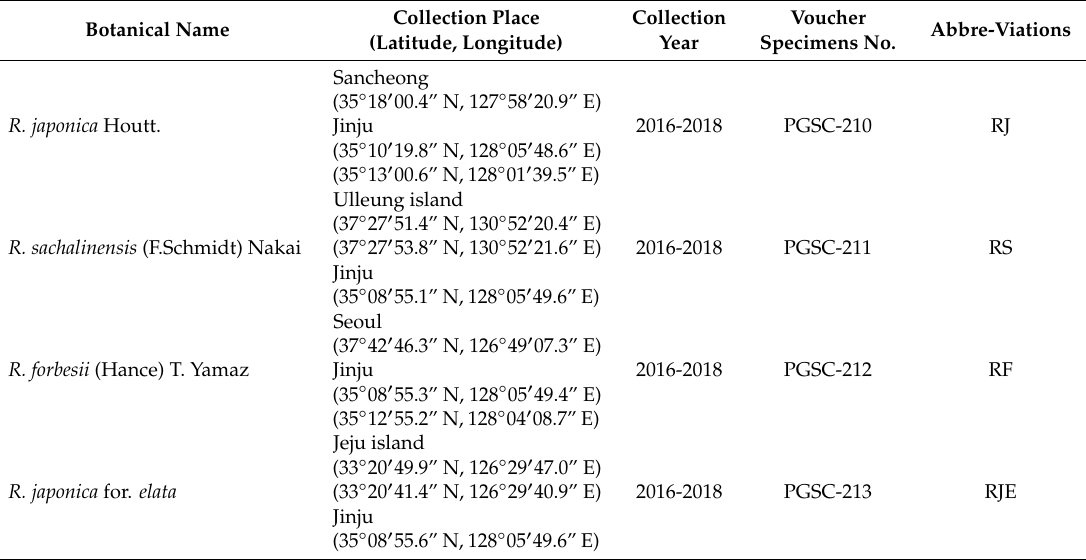
Table 7. A list of Reynoutria plants collected from